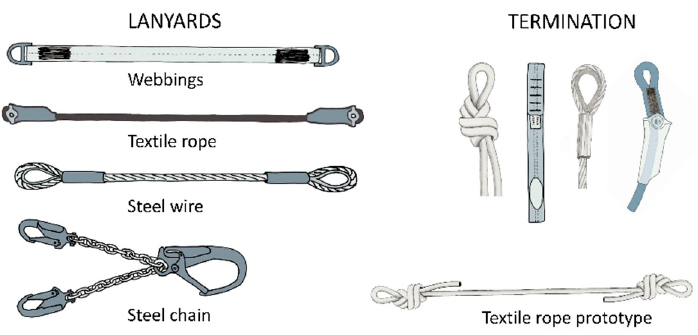
Figure 2. Di ff erent lanyards and terminations commonly used. Figure 2. Different lanyards and terminations commonly used.